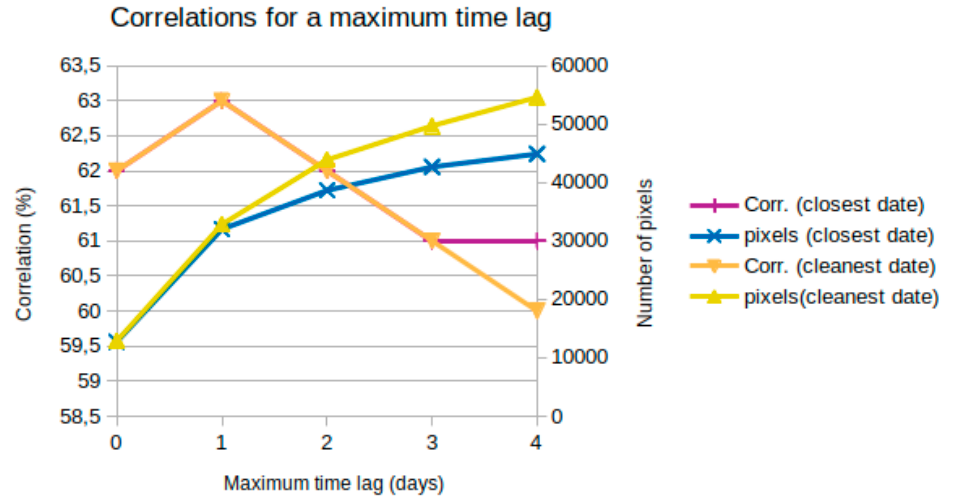
Figure 9. Evolution of the correlation coefficient between Sentinel-2 NDSI and Izas FSC and evolution of the number of pixels as a function of the time lag (plus or minus) for the “cleanest” and “closest” approaches.